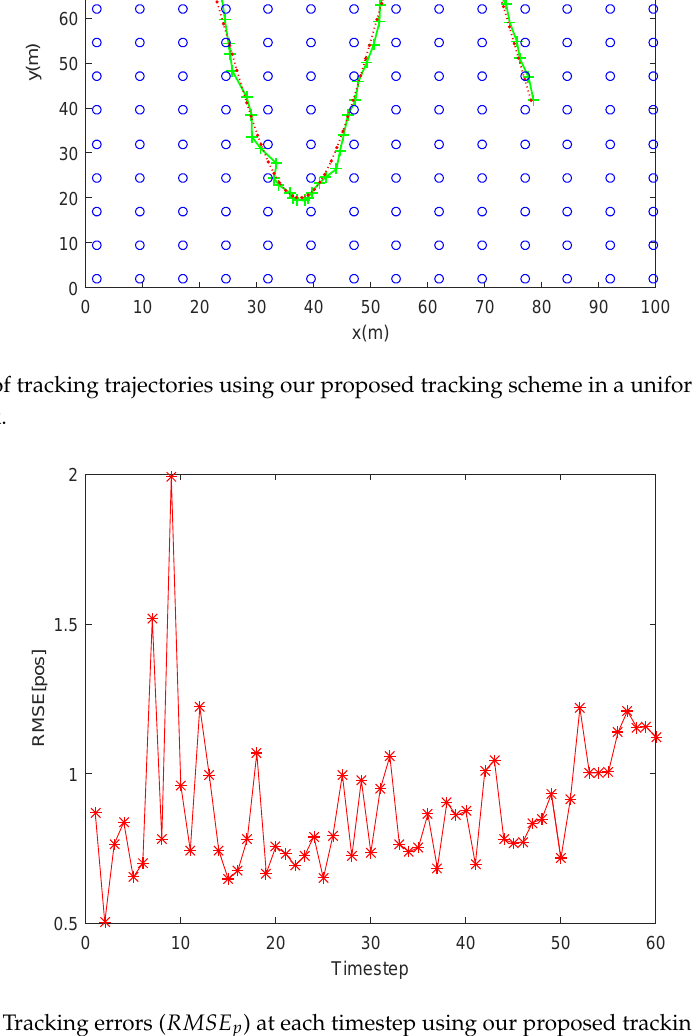
Figure 7. Tracking errors ( RMSE p ) at each timestep using our proposed tracking